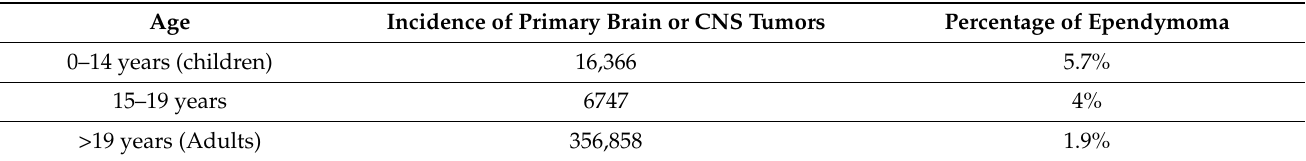
Table 2. Prevalence of ependymomas among the incidence of primary brain or central nervous system (CNS) tumors [33,46].